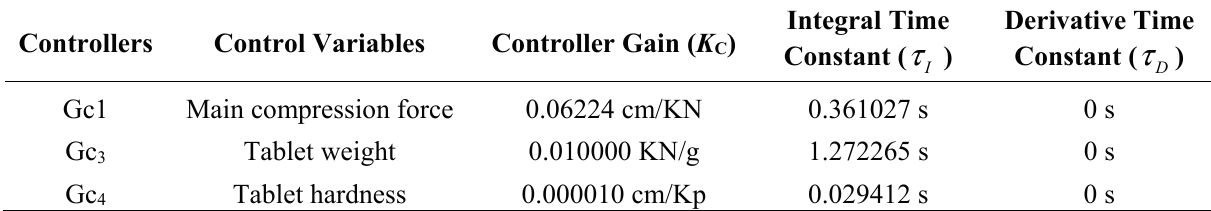
Table 3. Controller tuning